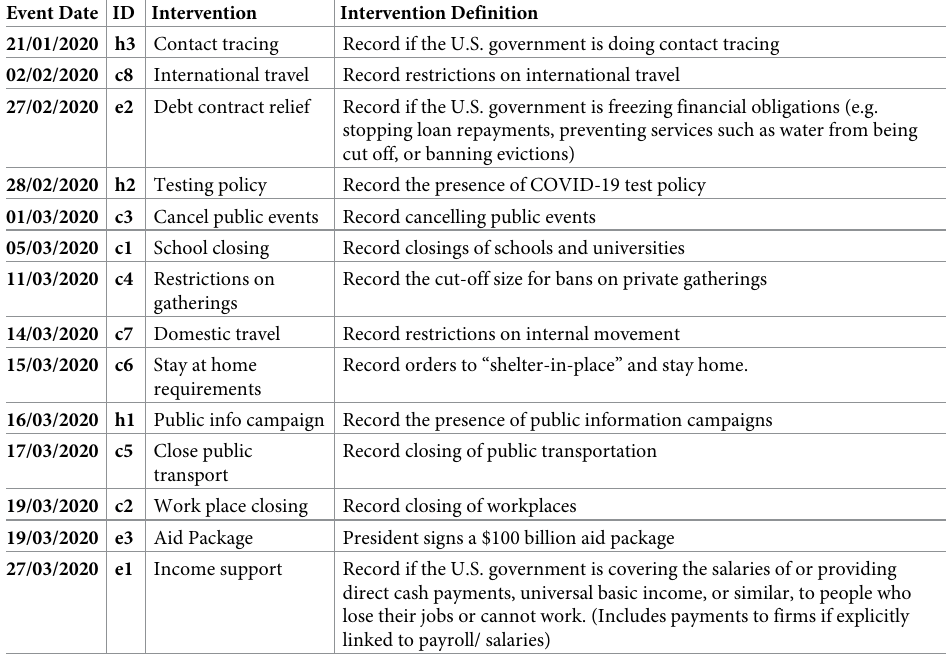
Table 2. Description of U.S.